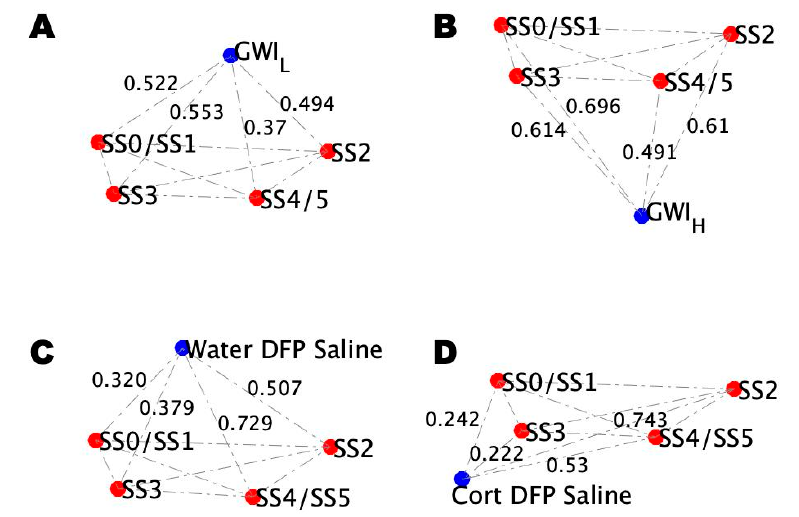
Figure 6. Comparison of the GWI trauma subtype blood profile topologies with mouse models at rest. ( A ) Topology of the distance between the simulated stable states for GWI L at rest. ( B ) Topology of the distance between the simulated stable states for GWI H at rest. ( C ) Topology of the distance between the simulated stable states from mice receiving a course of pure drinking water, an injection of DFP, and a follow-up injection of saline. ( D ) Topology of the distance between the simulated stable states from mice receiving a course of drinking water with CORT, an injection of DFP, and a follow-up injection of saline.